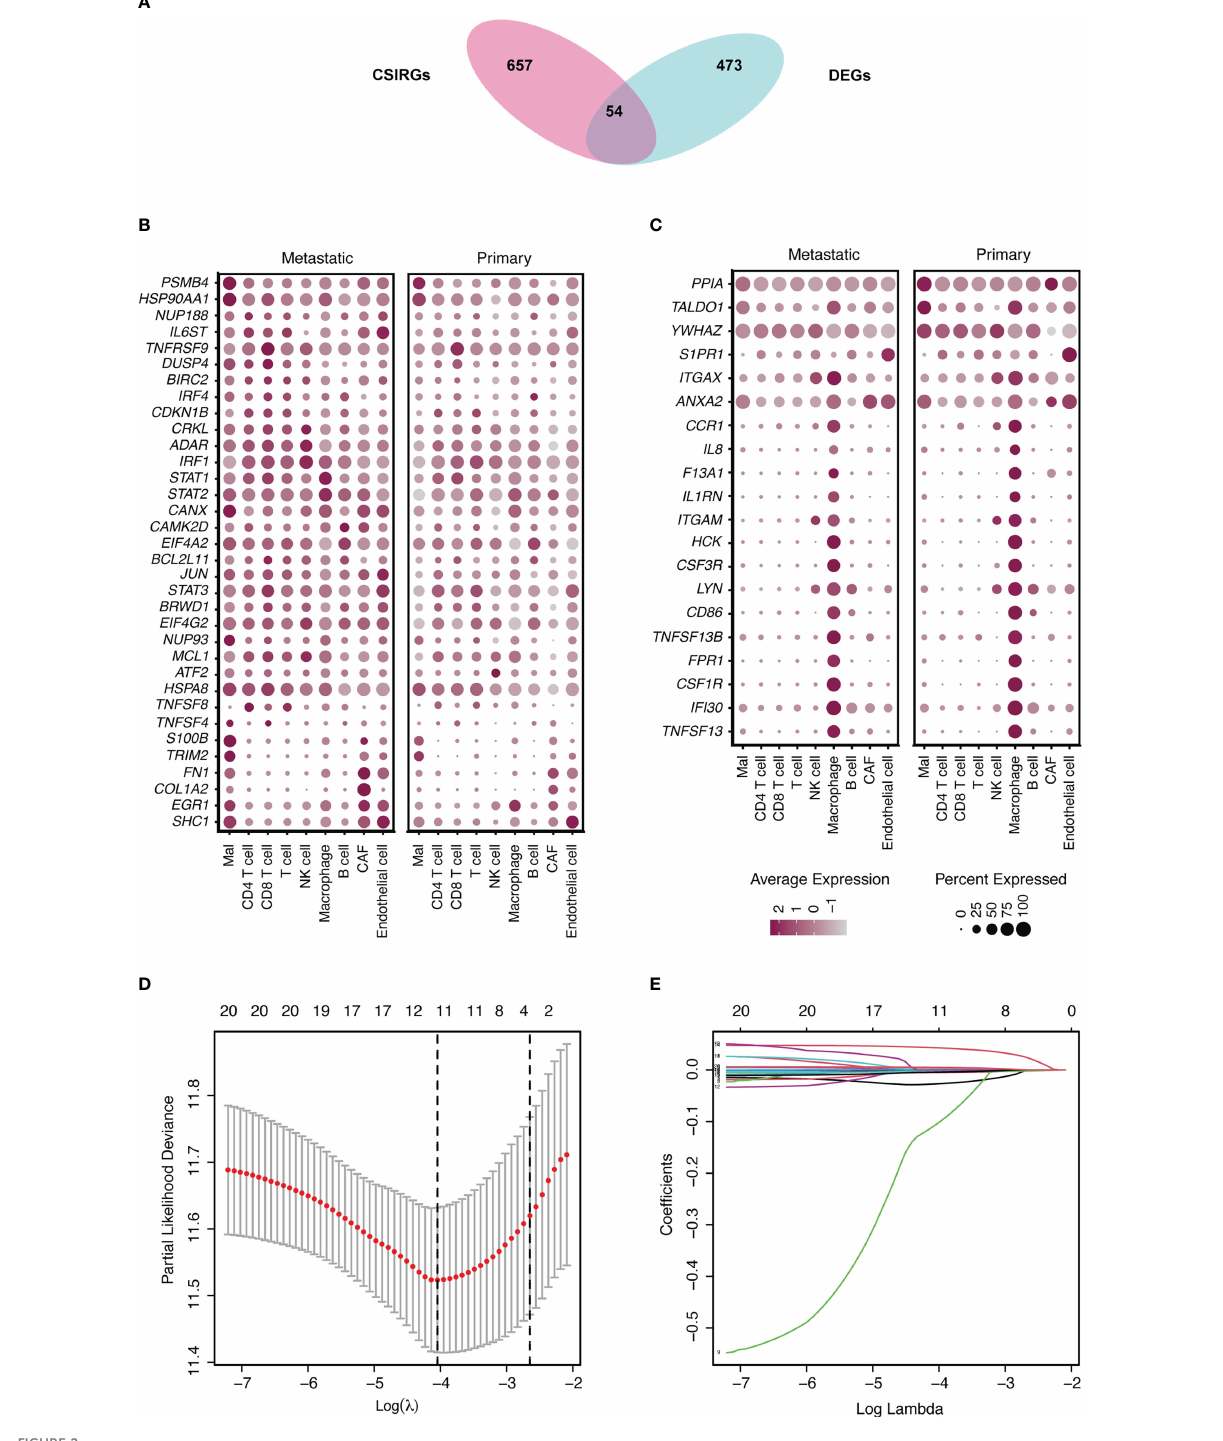
FIGURE 2 Identi fi cation of differentially expressed genes (DEGs) and cytokine signaling in immune-related genes (CSIRGs) between the metastatic melanoma and primary melanoma groups. (A) DEGs and CSIRGs in GSE115978 (|logFC| > 0.25 and adjusted P value < 0.05). (B) Dot plot showing the DEGs that were upregulated in the metastatic melanoma group. Mal: Malignant cells. (C) Dot plot showing the DEGs that were downregulated in the metastatic melanoma group. Mal: Malignant cells. (D, E) LASSO regression was performed on